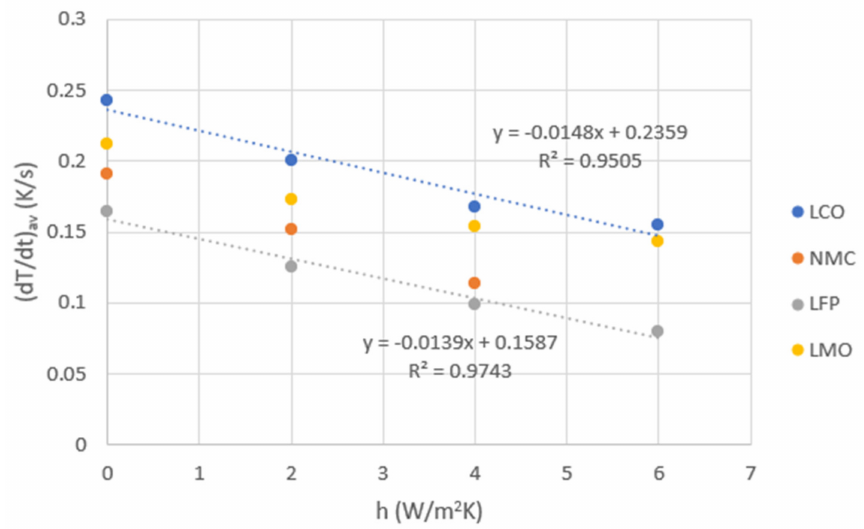
Figure 14. Heating rate as a function of h. Table 6. Thermal runaway ignition times for all cathodes at different ambient temperatures and heat exchange